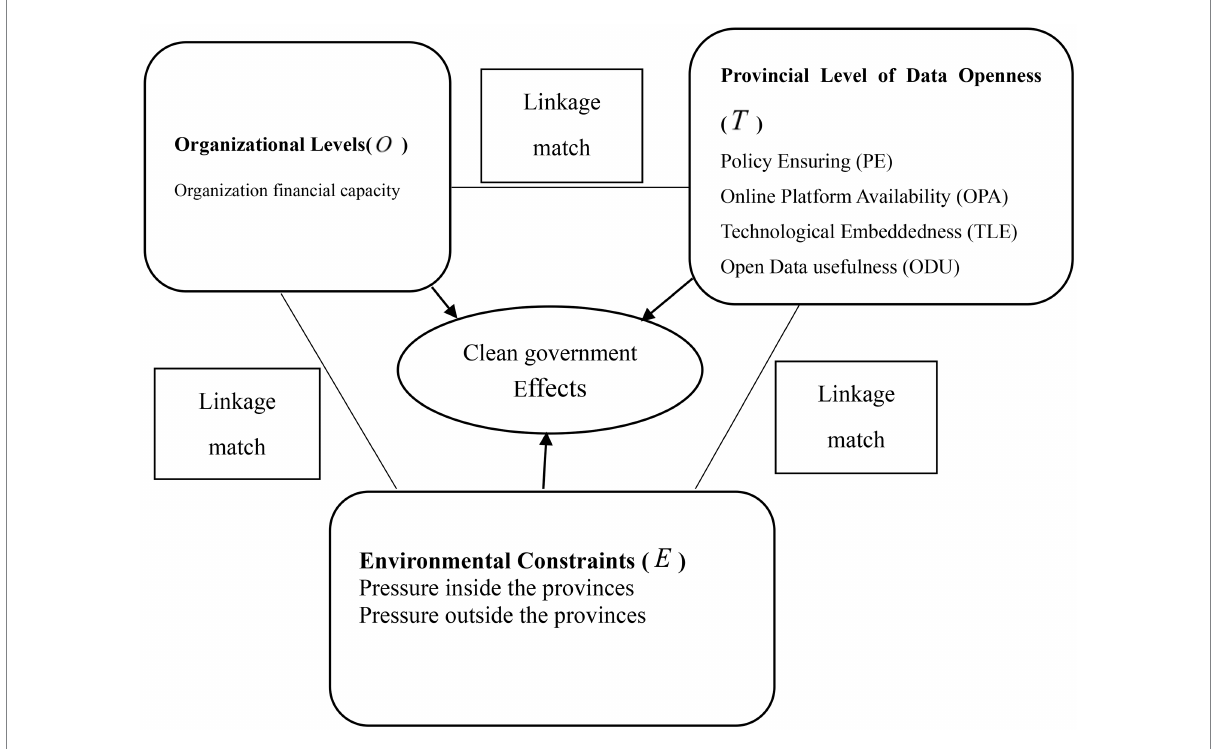
FIGURE 1 The government integrity conceptual